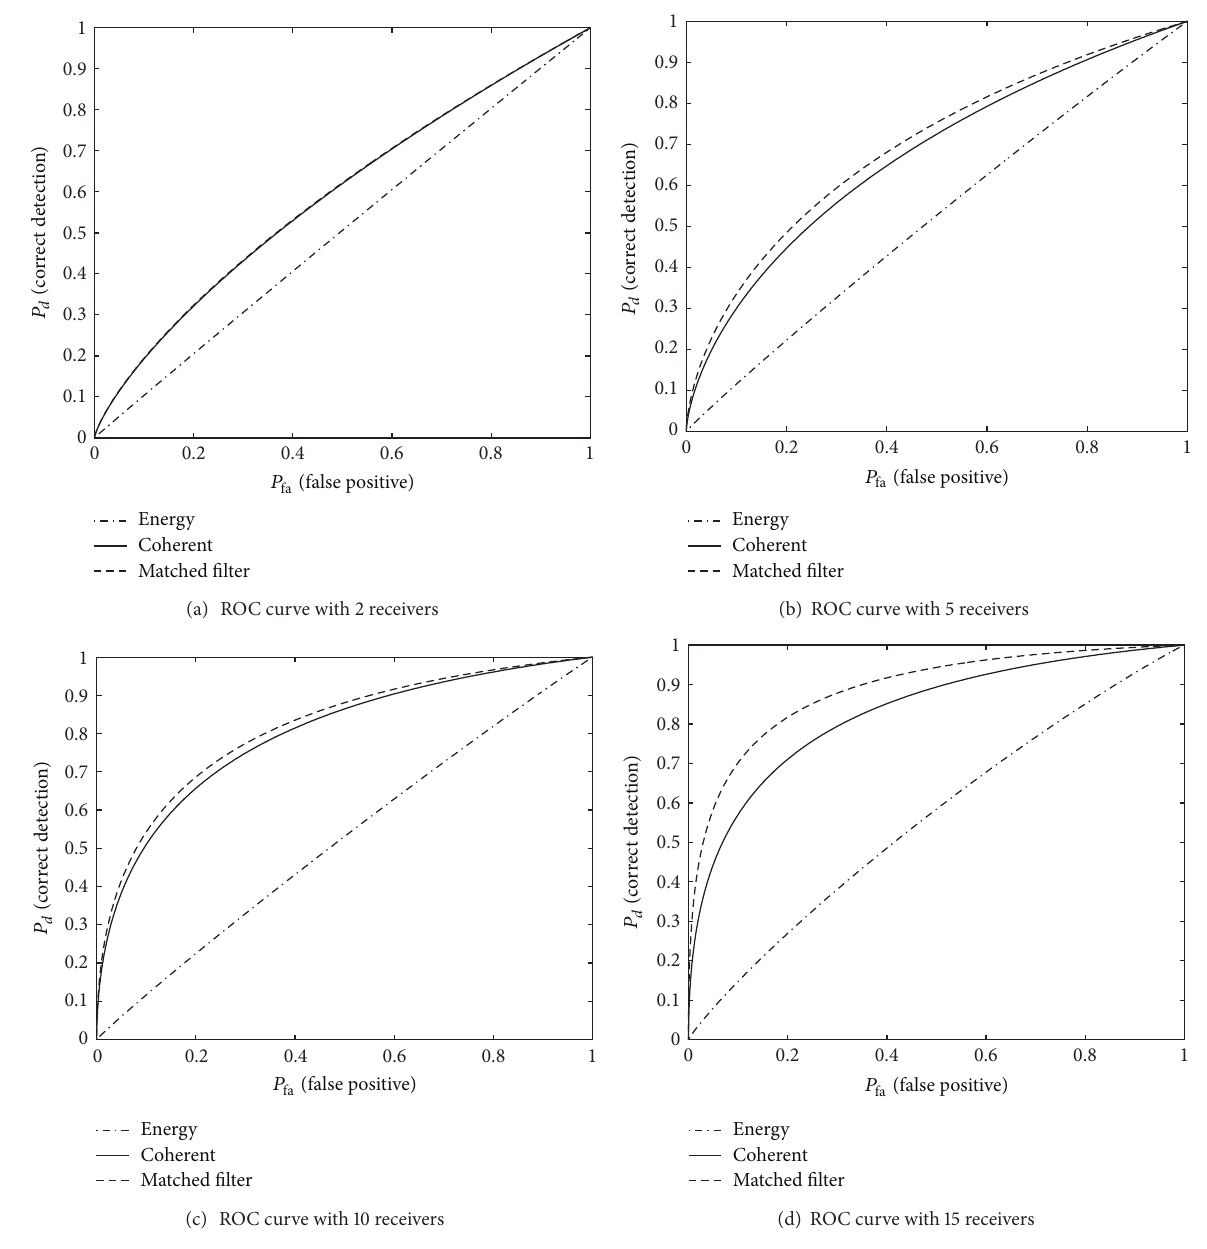
Figure 4: ROC curves for different number of